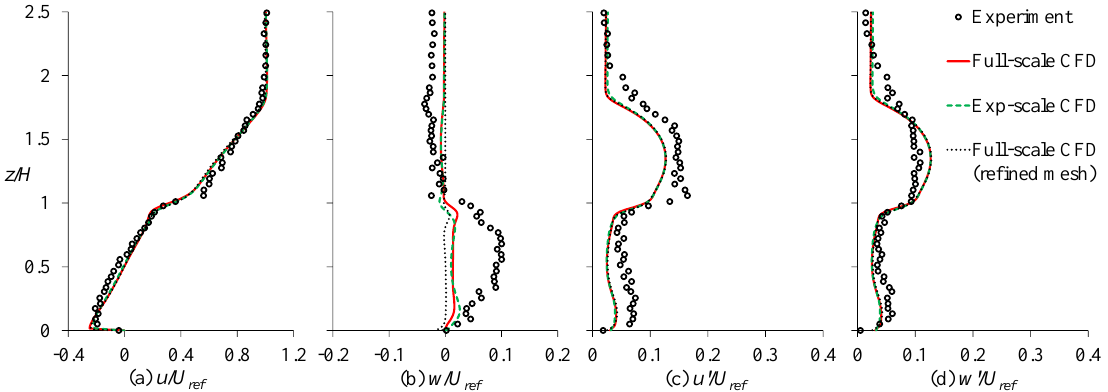
Figure 11. Normalized middle-line velocity profiles at canyon 4 comparing experimental and CFD results for the reference case. ( a ) mean stream-wise velocity, ( b ) mean vertical velocity, ( c ) stream-wise velocity fluctuation, and ( d ) vertical velocity fluctuation. “Exp-scale” and “Full-scale” are experimental scale and real scale in a built